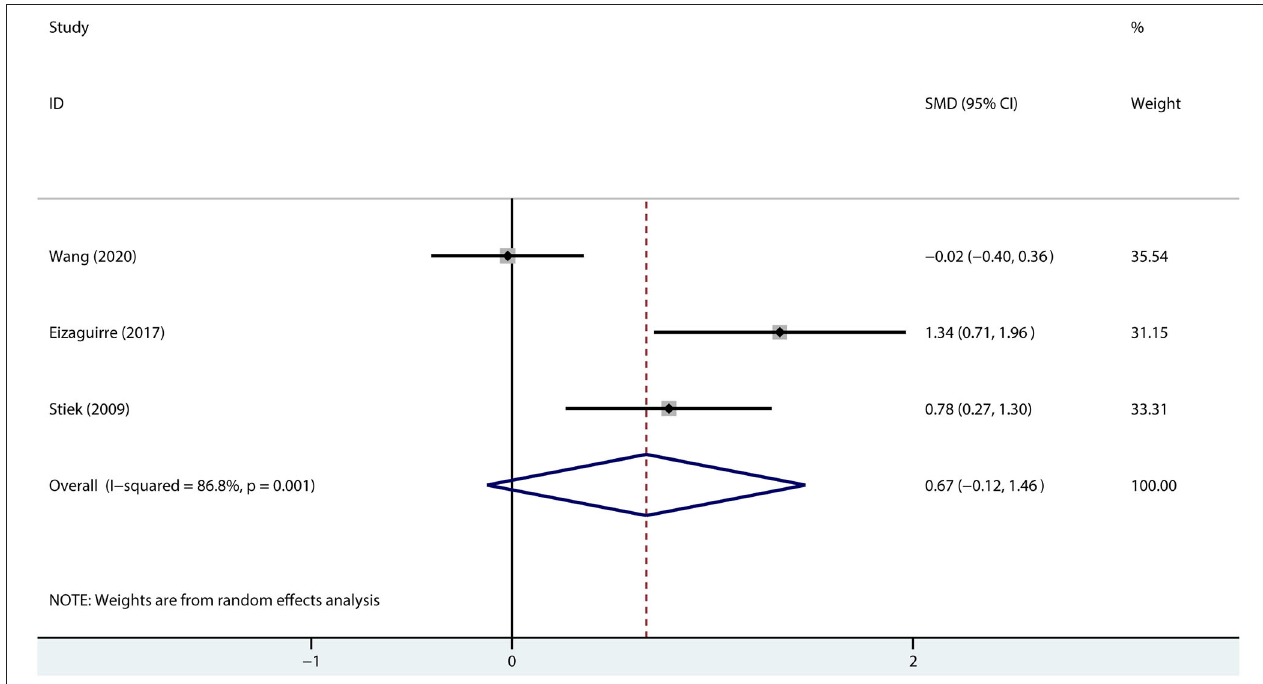
FIGURE 5 | A forest plot of the association between MG and depression.